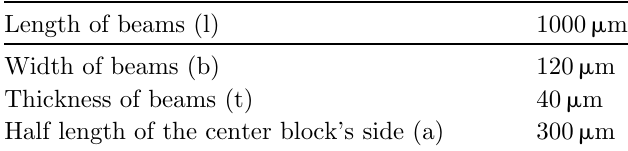
Table 3. Parameters of cross